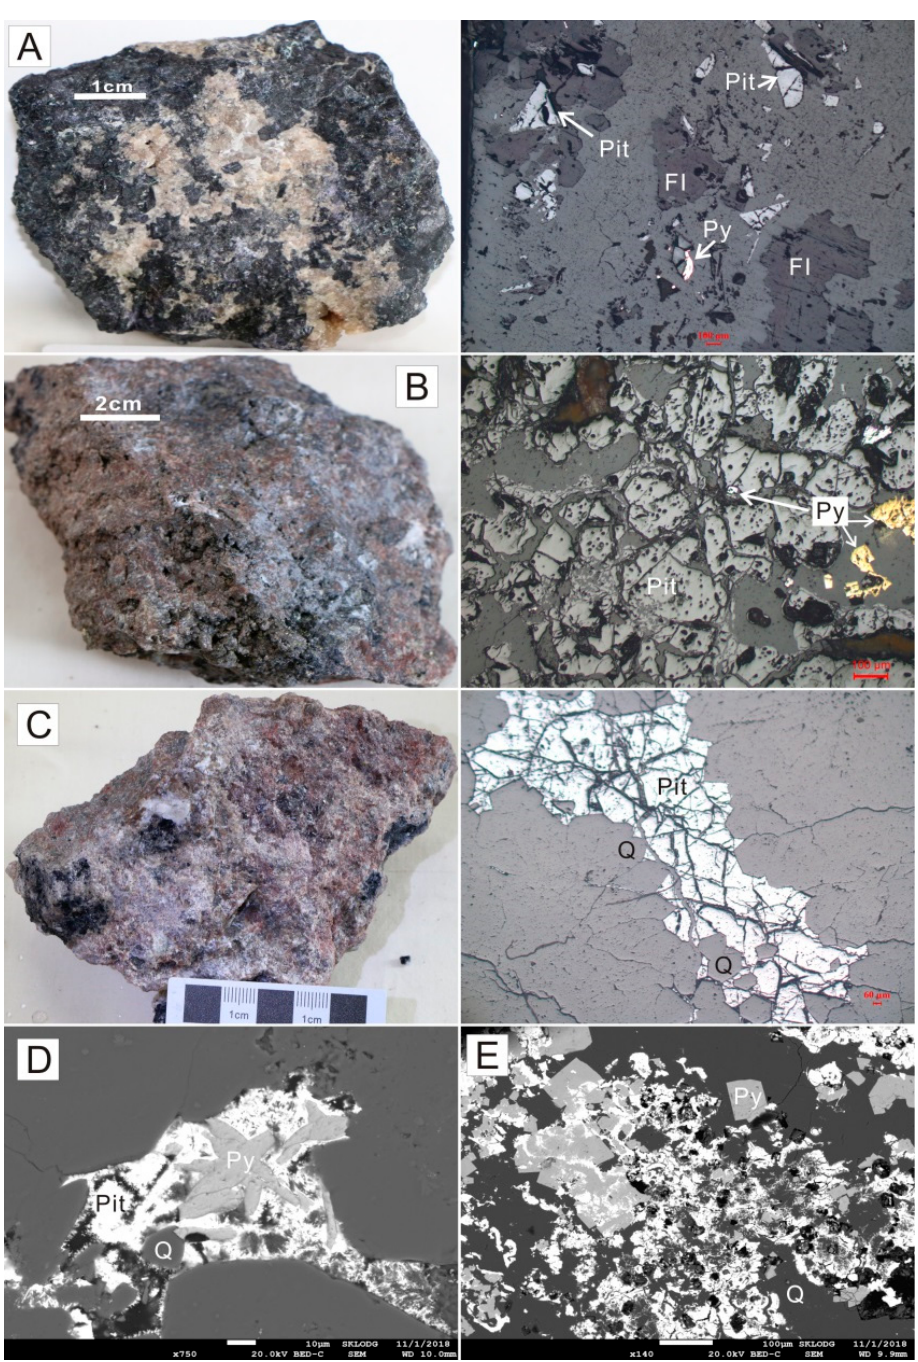
Figure 5. Major types of mineralization in the No. 302 uranium deposit. ( A – C ) the mineralization from the Mianhuakeng deposit (Left) and its corresponding mineral characteristics under the microscope (Right). ( A , B ) the mineral association is generally the purple-black fluorite + pyrite + pitchblende + microcrystalline quartz. ( C ) red ore. The mineral association in this type of mineralization is usually hematite + red microcrystalline quartz + pitchblende. ( D , E ) the back-scattered electron images. ( D ) the syn-mineralization colloform pyrite intergrowth with pitchblende and quartz. ( E ) the network pitchblende, pyrite and quartz veins. Pit: pitchblende; Fl: fluorite; Py: pyrite; Q: quartz.